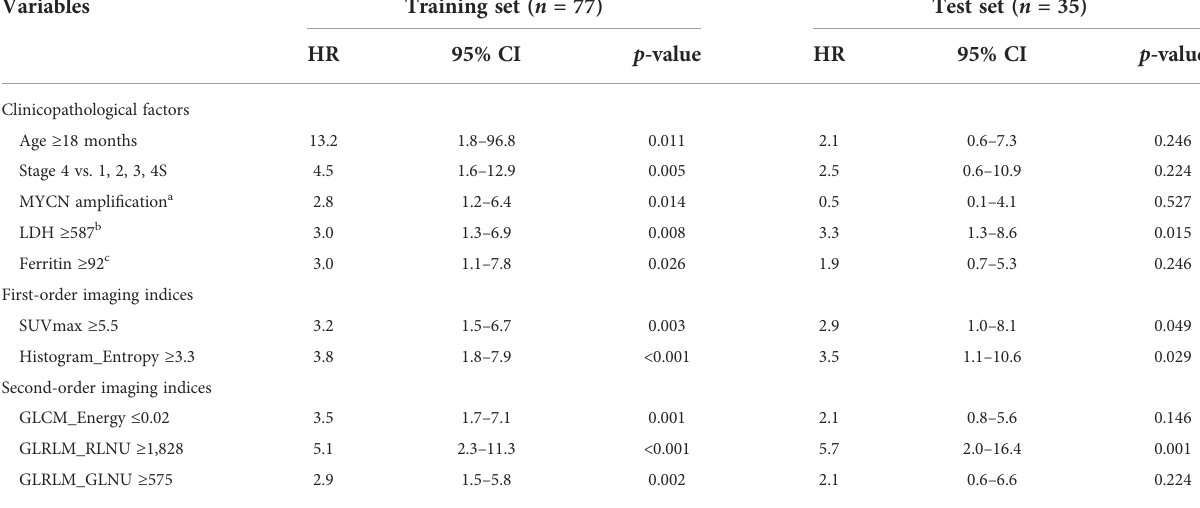
TABLE 2 Univariate Cox regression analyses for event-free